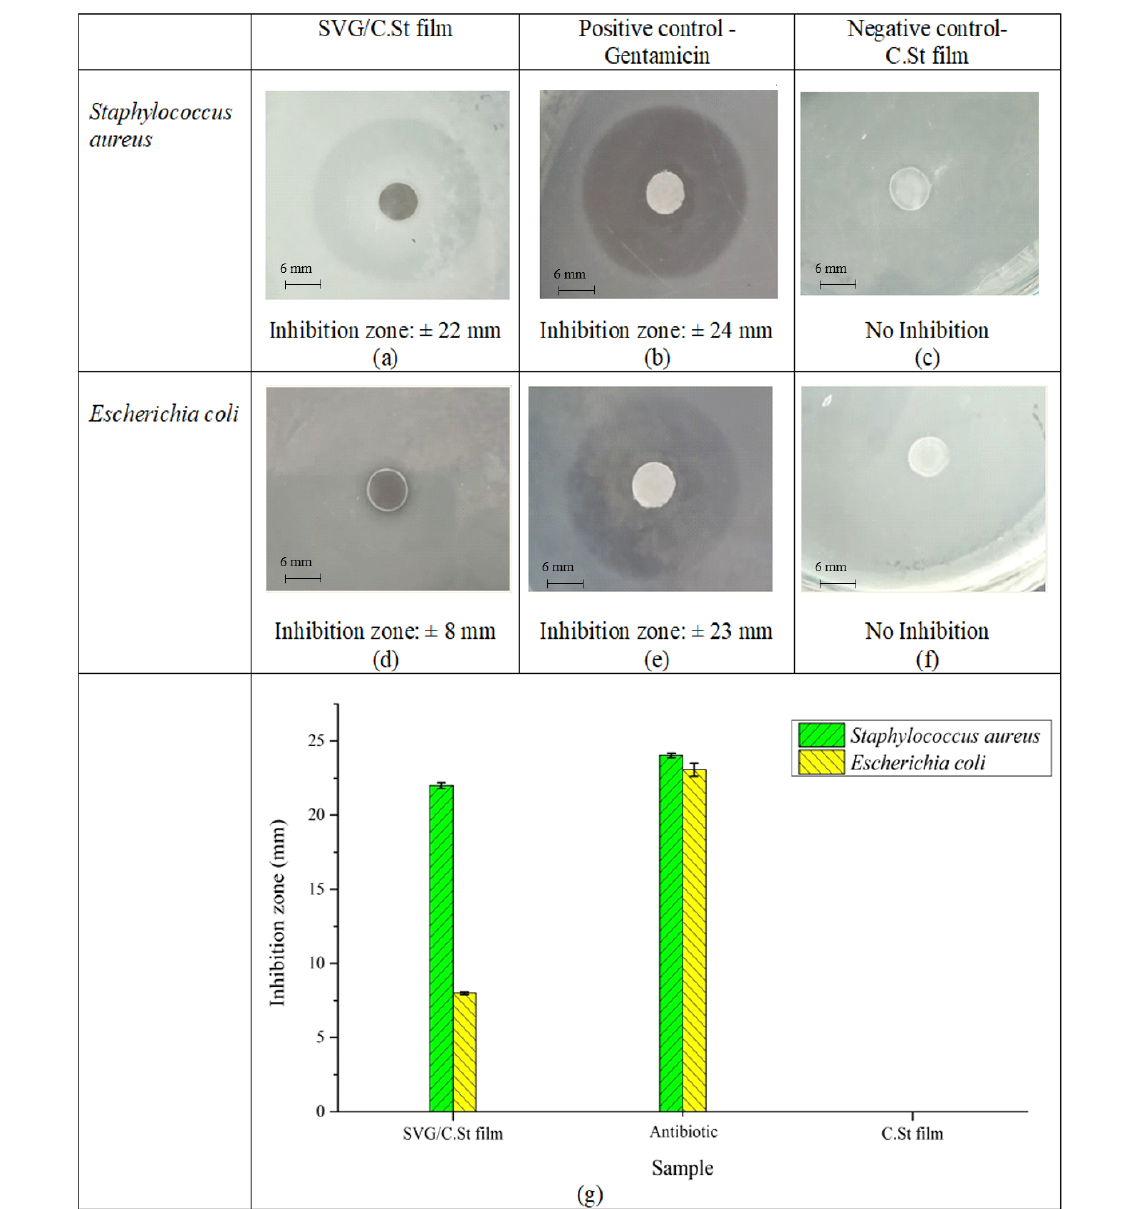
Figure 2: Antibacterial activity of (a) SVG/C.St film, (b) Antibiotic - Gentamicin (positive control) and (c) C.St film (negative control) agains t Staphylococcus aureus and (d) SVG/C.St film, (e) Antibiotic - Gentamicin (positive control) and (f) C.St film (negative control) against Escherichia coli (g) The relationship between inhibition zone of SVG/C.St film, C.St film (negative control) and positive control Antibiotic - Gentamicin (positive control) against Escherichia coli and Staphylococcus aureus , by disc diffusion